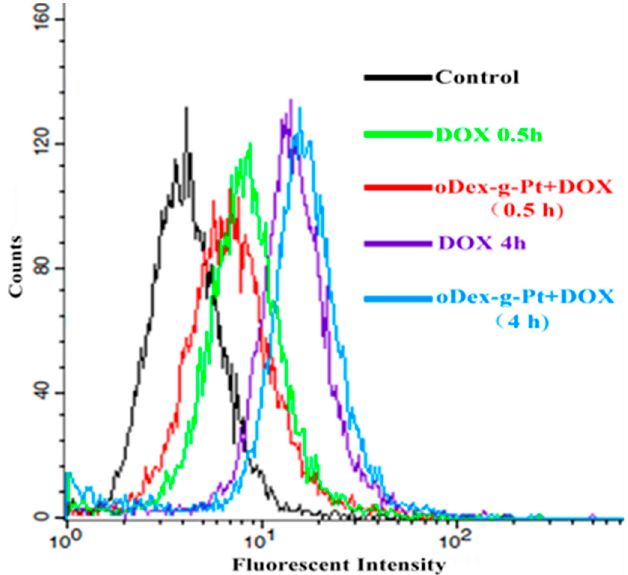
Figure 8. Cellular uptake. FCM of HeLa cells after incubation with free DOX and